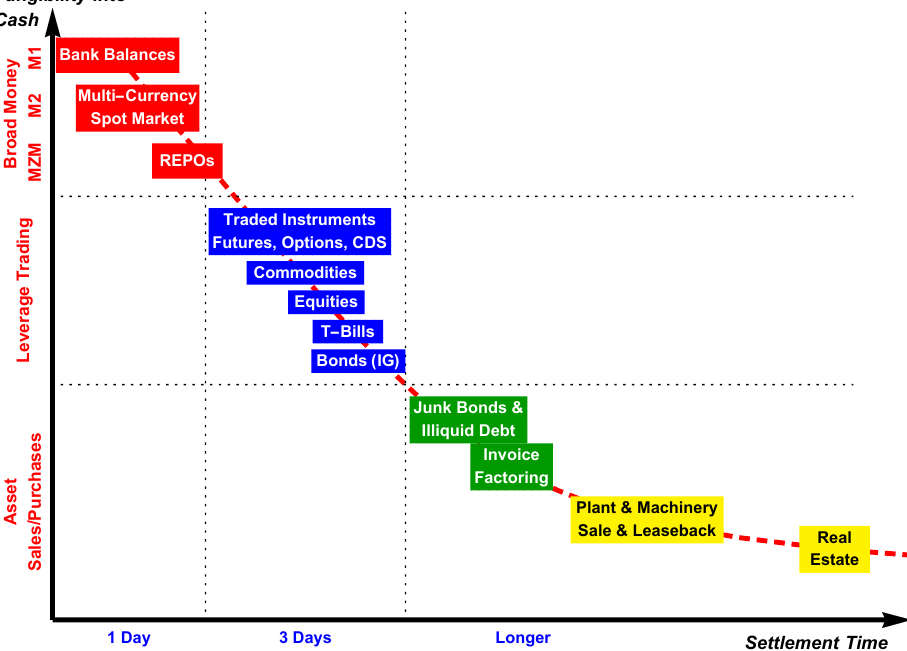
Figure 5. The Liquidity Continuum: variation of monetary, financial-leverage, and real-asset fungi- bility vs. settlement